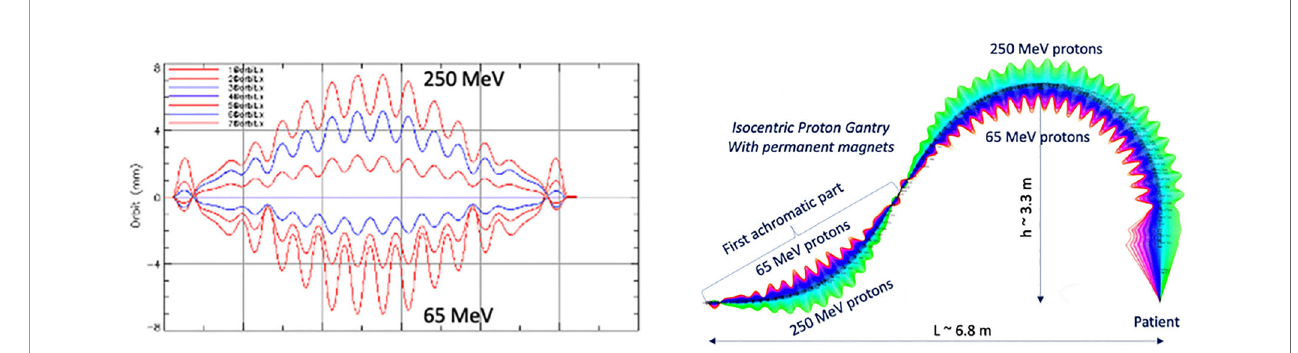
FIGURE 9 | Orbit shape with varying energy (left) showing an energy acceptance range of 65 – 250 MeV. Orbit offsets within the permanent FFA gantry for PBT (right). Note the orbit offsets with energy are magni fi ed for clarity in the right hand image and are around 15 mm, as shown on the